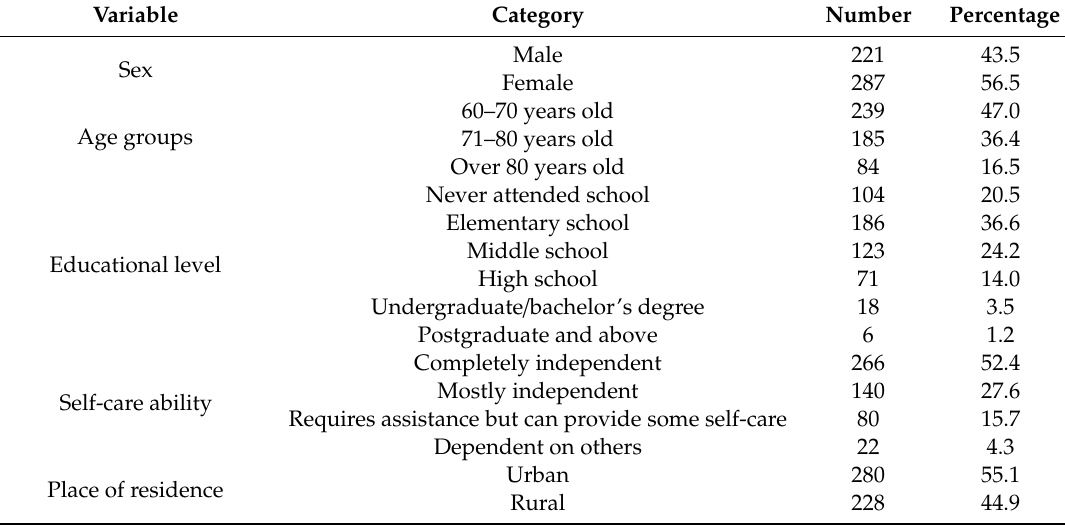
Table 1. Sample population